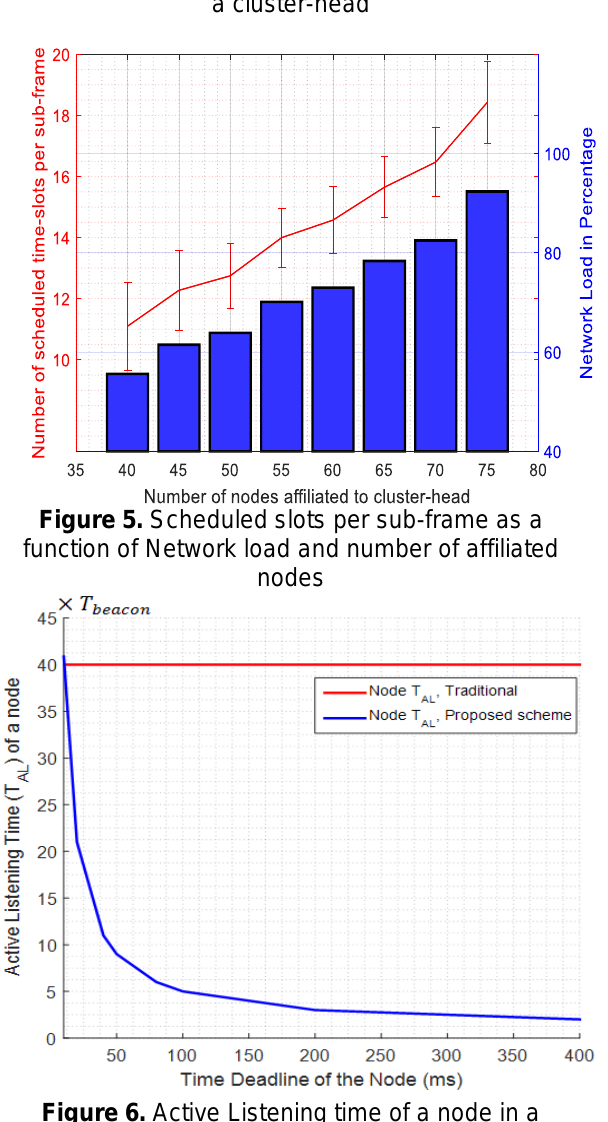
Figure 6. Active Listening time of a node in a superframe of duration 𝑇